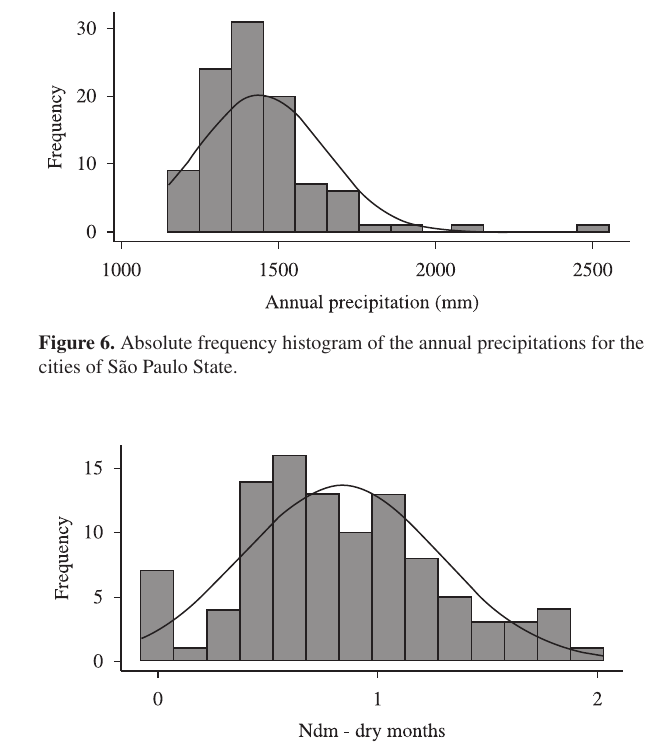
Figure 7. Absolute frequency histogram of the dry months for the cities of São Paulo State.